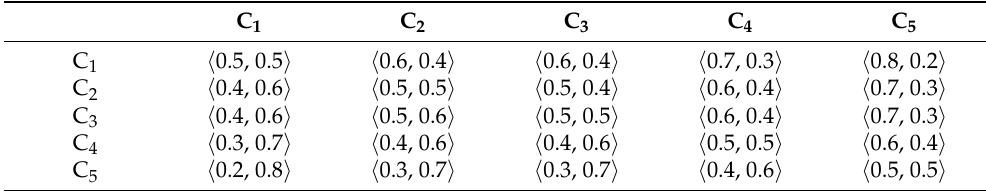
Table 9. Aggregated decision matrix in PF–AHP for the sub-criteria C ( CI = 0.0317228, CR = 0.0283239). C